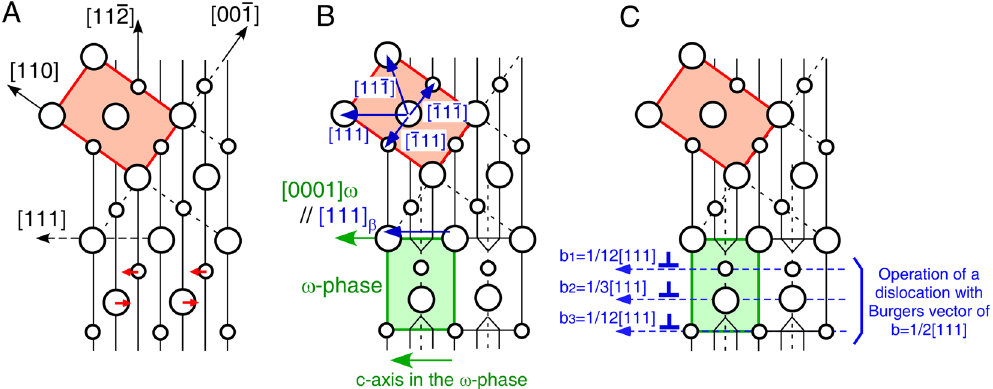
Figure 6. Possible model on the variations in atomic arrangement in bcc β -Ti during the dynamic precipitation of ω -phase. The observed direction is parallel to the [ 1 10] direction, and the large and small circles indicate the atoms in the plane of the paper and in the lower plane, respectively. ( A ) ω -phase formation in the β -matrix phase is crystallographically associated with shifts of atoms along opposite < 111 > directions, as indicated with red arrows. ( B ) During formation of the ω -phase, the atomic arrangement is conserved in only one of the four < 111 > directions, i.e., only the [111] direction. ( C ) According to the model proposed by Lasalmonie and Chaix 36 , if the dislocation with the Burgers vector of b = 1/2[111] is dissociated into the three b /6, 2 b /3, and b